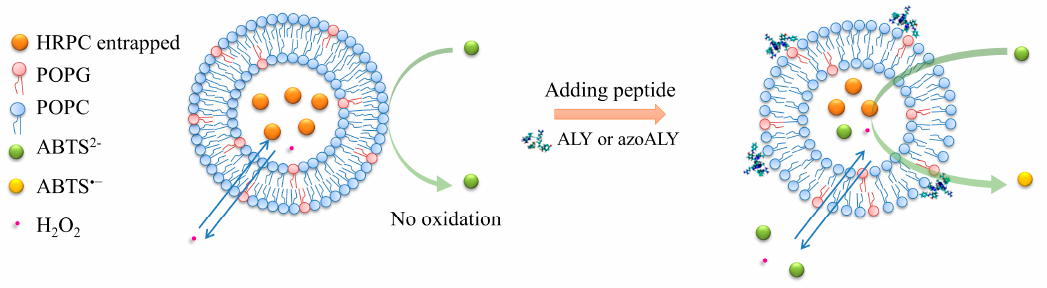
Figure 6. Horseradish peroxidase isoenzyme C enzyme (HRPC) enzyme leakage from large unilamellar vesicles (LUVs), measured with H 2 O 2 and ABTS 2 − , the latter being membrane impermeable.